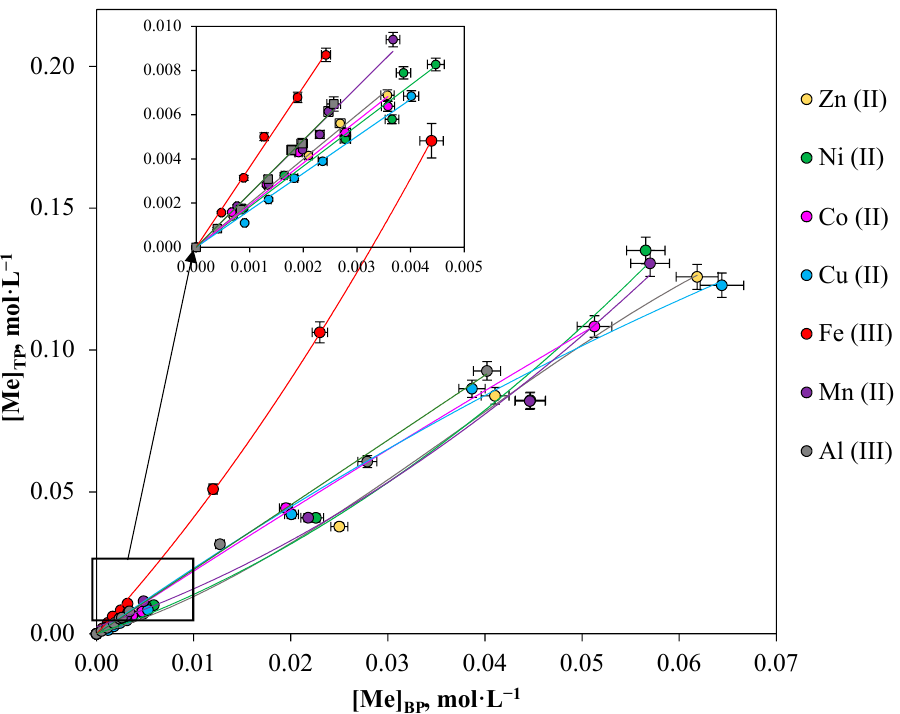
Figure 2. Metal extraction isotherms in the PEO 1500 (16.3 wt%)-NaNO 3 (36.0 wt%)-H 2 O system: [Me] in = 0–0.1 mol·L − 1 , temperature: 298.15 K, and phase ratio: 1:1.